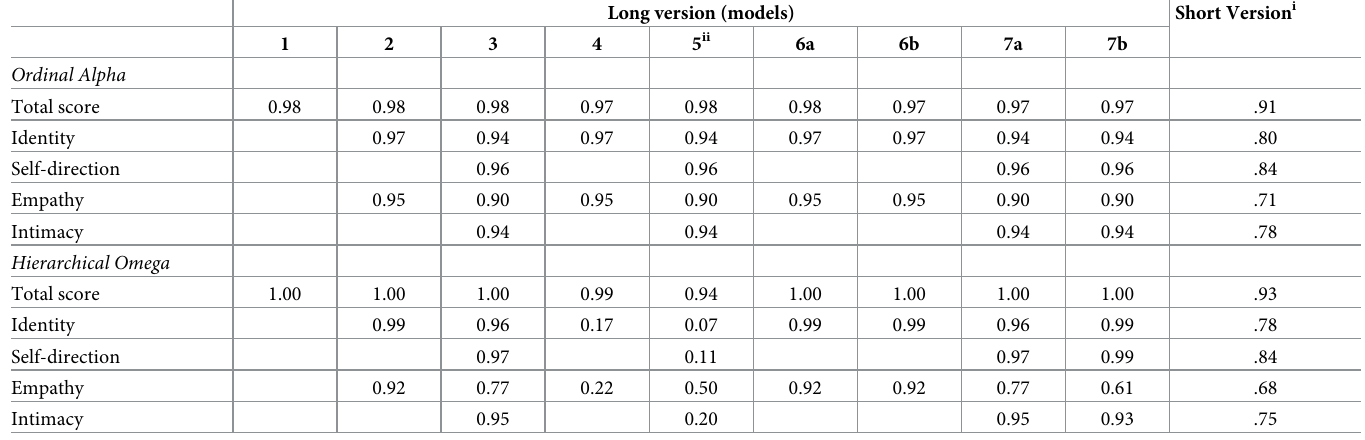
Table 2. Factor reliabilities for the long and short